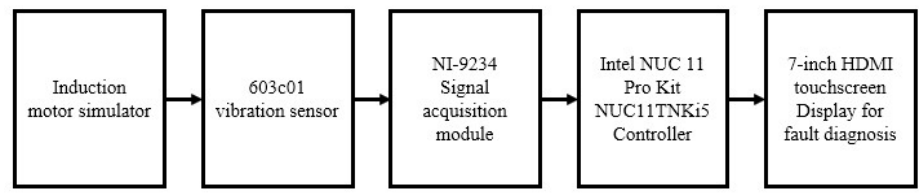
Figure 2. Block diagram of the experimental laboratory setup. Table 1. Specifications of the vibration sensor used for data acquisition and fault diagnosis.